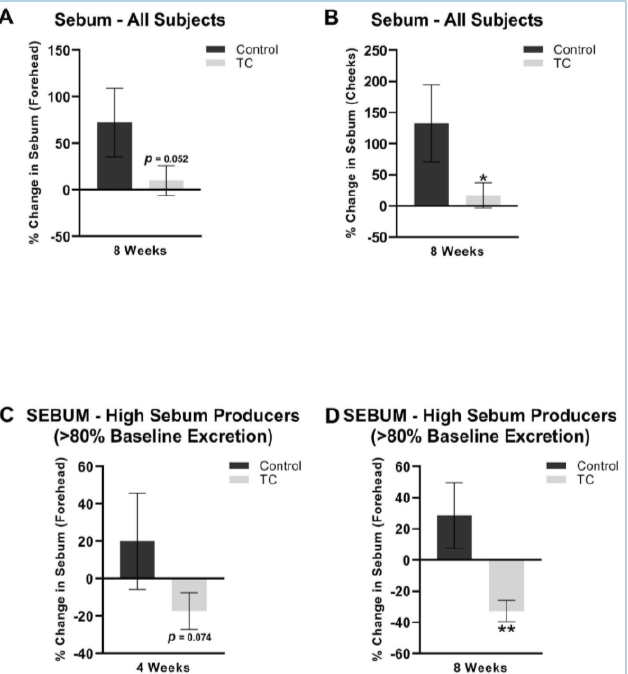
Figure 3. ( A ) Forehead sebum production after 8-weeks, all subjects. ( B ) Cheek sebum production after 8-weeks, all subjects. ( C ) Forehead sebum production after 4 weeks, high sebum producers (>80% baseline excretion). ( D ) Forehead sebum production after 8 weeks, high sebum producers (>80% baseline excretion). All presented data is compared to pretreatment baseline. N = 38 for ( A , B ), N = 15 for ( C , D ). * p < 0.05, ** p < 0.01.